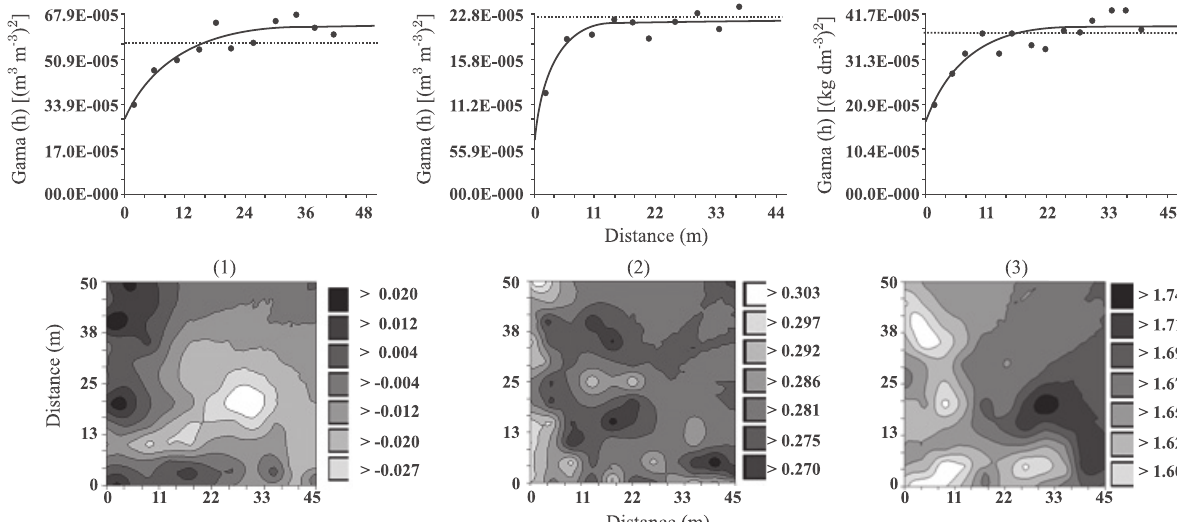
Figure 2. adjusted semivariogram and kriging maps of some properties in different layers: 1) Microporosity in layer 0-0.10 m (#Mi1), 2) total porosity in layer 0.10-0.20 m (tp2), 3) Bulk density in layer 0-0.10 m (Bd1).